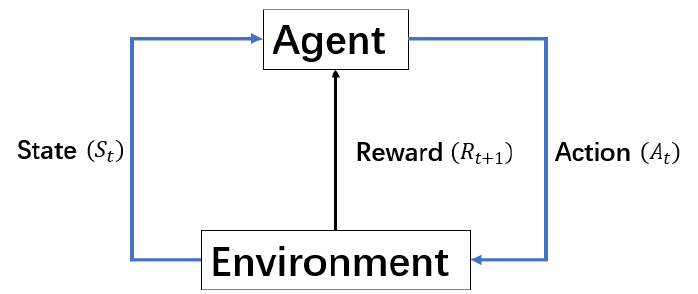
Figure 1. The Markov decision process framework.